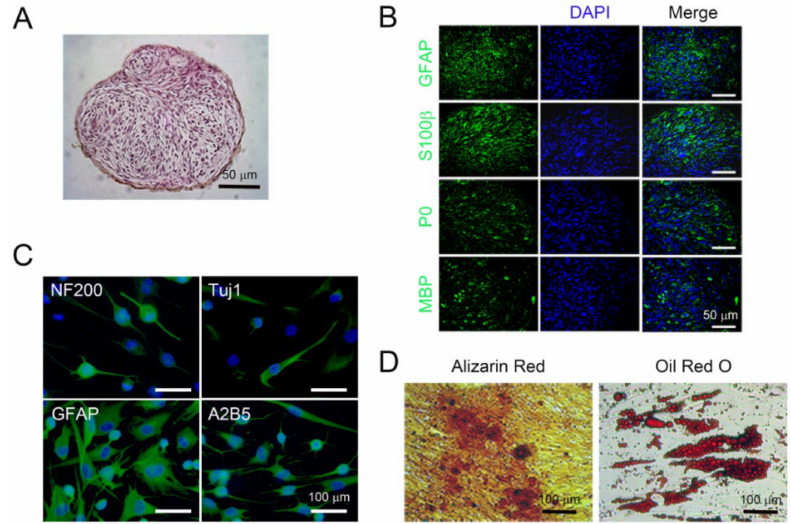
Figure 2. Multipotent differentiation potential of isolated peripheral nerve-derived stem cells (PNSCs) in vitro. ( A ) Isolated PNSCs were induced to become Schwann cell-like cells. Under suspension- culture conditions for seven days, PNSCs formed multicellular spheroid structures with fascicular arrangements. ( B ) Spheroid PNSCs expressed markers for committed Schwann cells (GFAP and S100 β ) and for myelin (P0 and MBP). ( C ) PNSCs induced to become neuroglia-lineage cells ex- pressed neuronal markers (NF200 and Tuj1), a glial marker (GFAP), and an oligodendrocyte marker (A2B5). ( D ) PNSCs induced to become osteocytes and adipocytes exhibited depositions of mineral crystals and cytoplasmic accumulation of fat vacuoles visualized by Alizarin Red and Oil Red O staining,